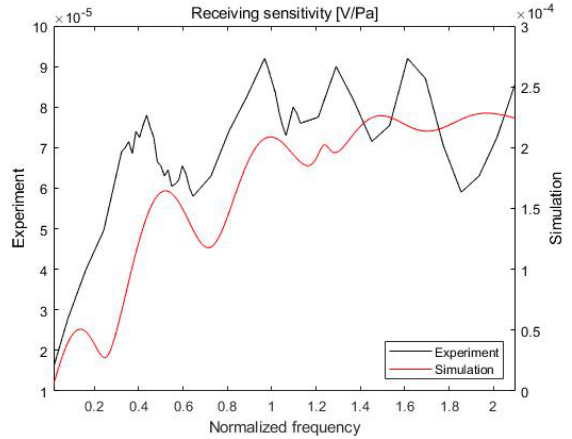
Figure 7. Receiving sensitivity of the proposed sensor.